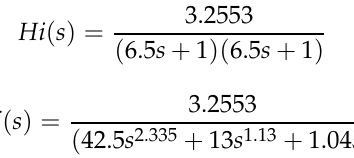
Figure 2. Comparison between simulated and experimental data for experiment 2 using L. plantarum .